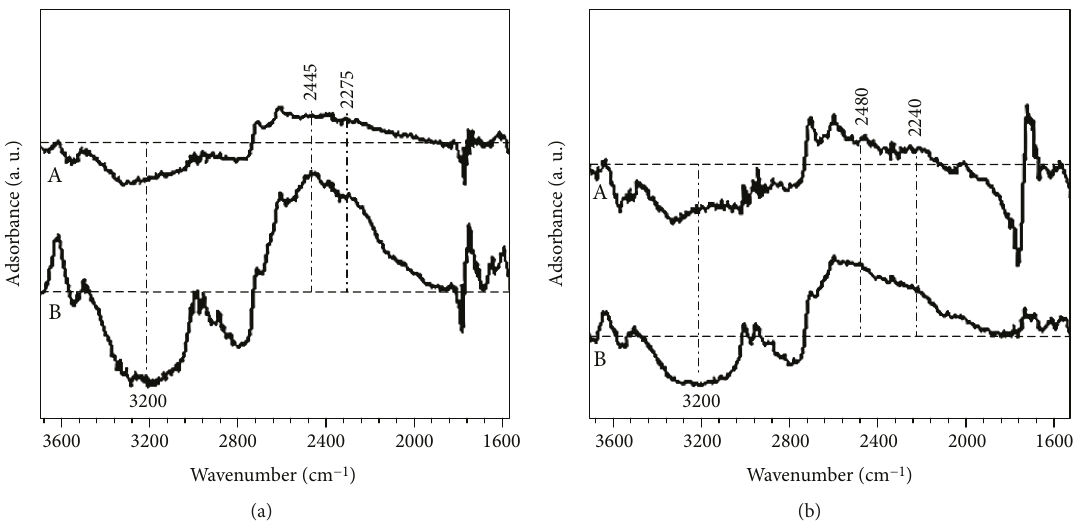
Figure 8: DR-FTIR subtraction spectra in the range 3700 – 1550 cm − 1 of outgassed samples after interaction with D continuous plasma treated (front) and (b) P